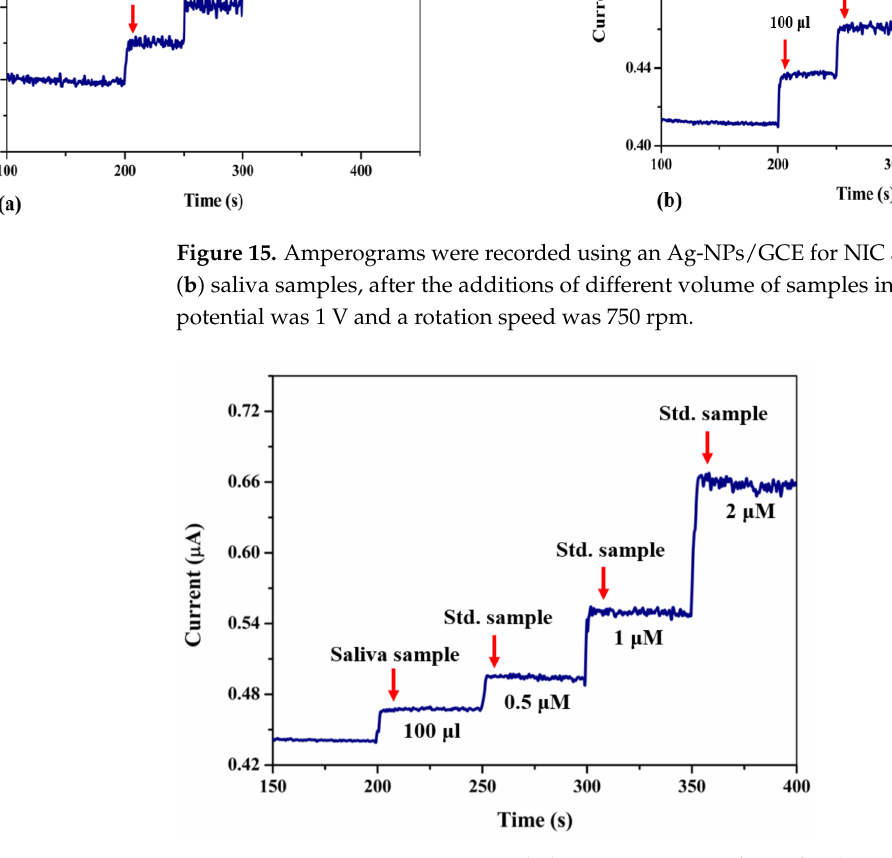
Figure 16. Amperogram was recorded using an Ag-NPs/GCE for detection of NIC in saliva sample along with spiking of standard NIC solution in to 0.1 M PBS under a rotation speed of 750 rpm. The applied potential was 1 V. Table 3. The determination of NIC in saliva samples using